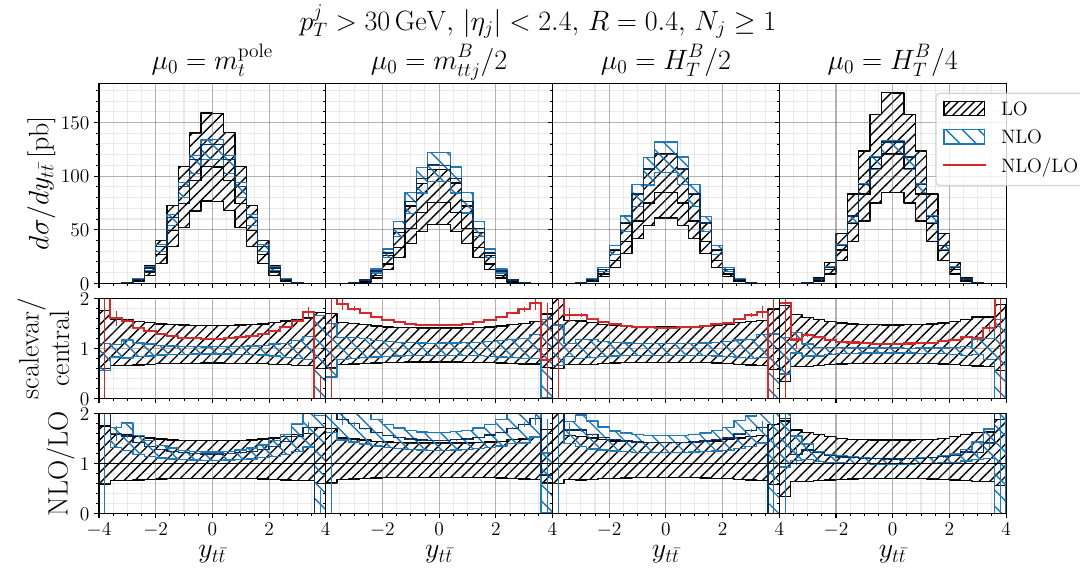
Figure 13 . Same as in figure 7, but for the y